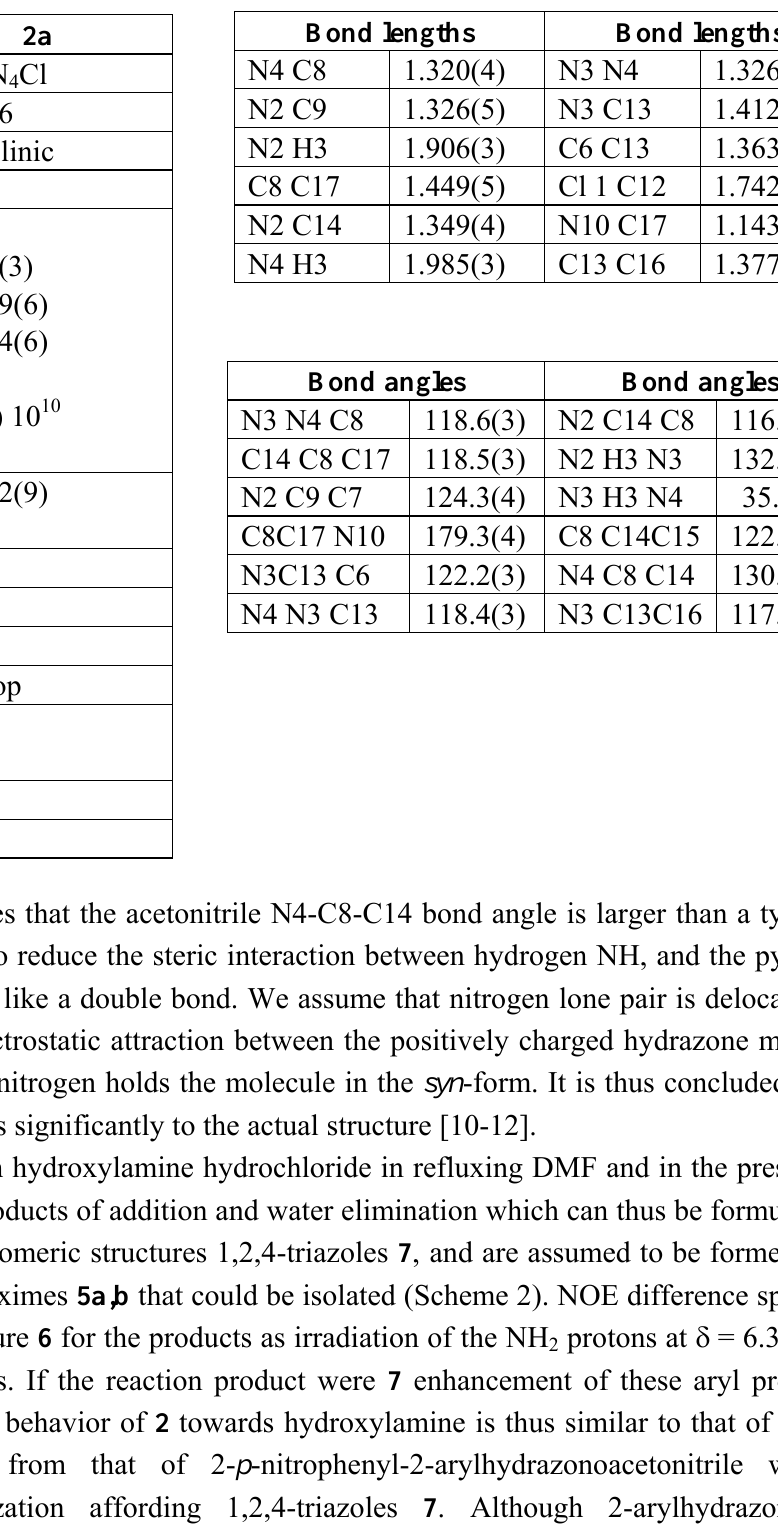
Table 1. Crystal data and structure refinement for compound 2a